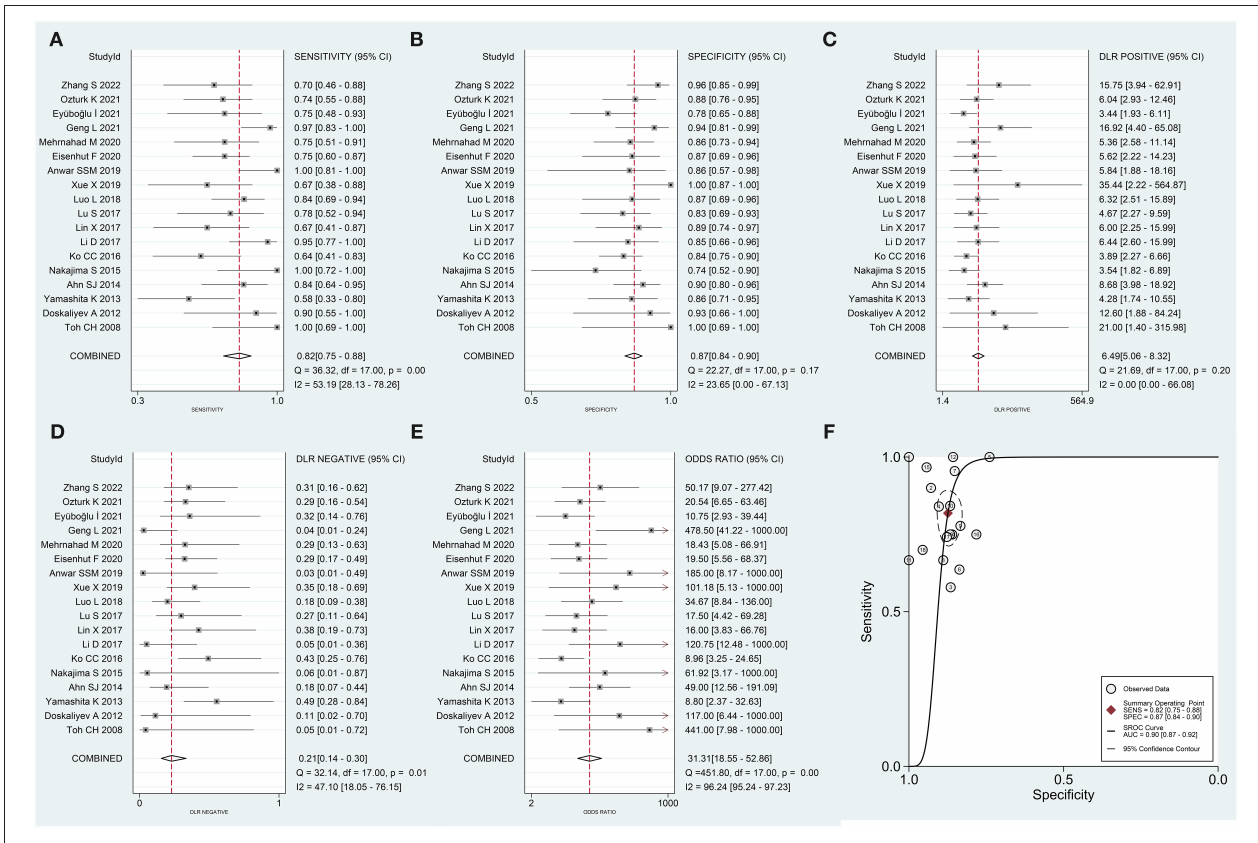
FIGURE 3 | Forest plot generated for pooled (A) sensitivity, (B) specificity, (C) positive likelihood ratio (PLR), (D) negative likelihood ratio (NLR), (E) diagnostic odds ratio (DOR), and (F) area under the curve (AUC) recorded for the summary receiver operating characteristic (SROC)